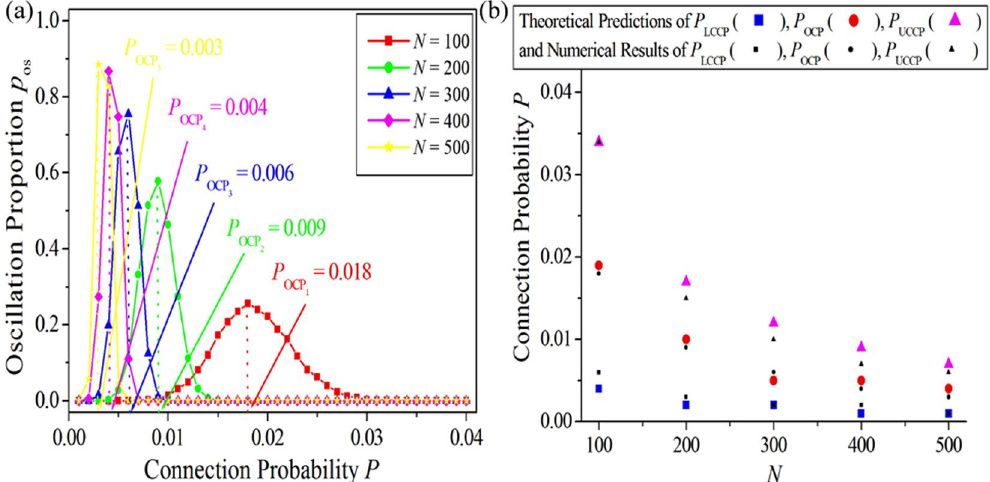
Figure 6. ( a ) The dependence of the oscillation proportion p os on the connection probability P for different system sizes N in EERRNs. Here other parameters are chosen as a = 0.90, b = 0.04, ε = 0.04, and D = 1.1. N ALL = 5000 independent randomly constructed excitable Erdös-Rényi networks are performed for each set of parameters. The OCPs P OCP for each oscillation proportion curve are indicated. ( b ) The dependence of theoretical predictions (shown by large coloured symbols) and numerical results (shown by small black symbols) of P LCCP , P OCP and P UCCP on system size N